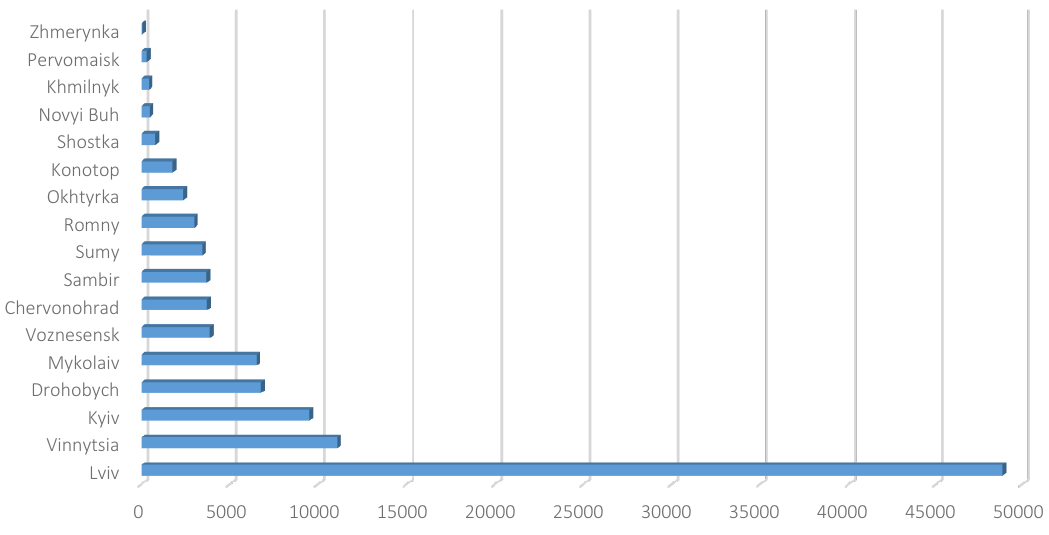
Figure 1. Number of Facebook subscribers to official city pages